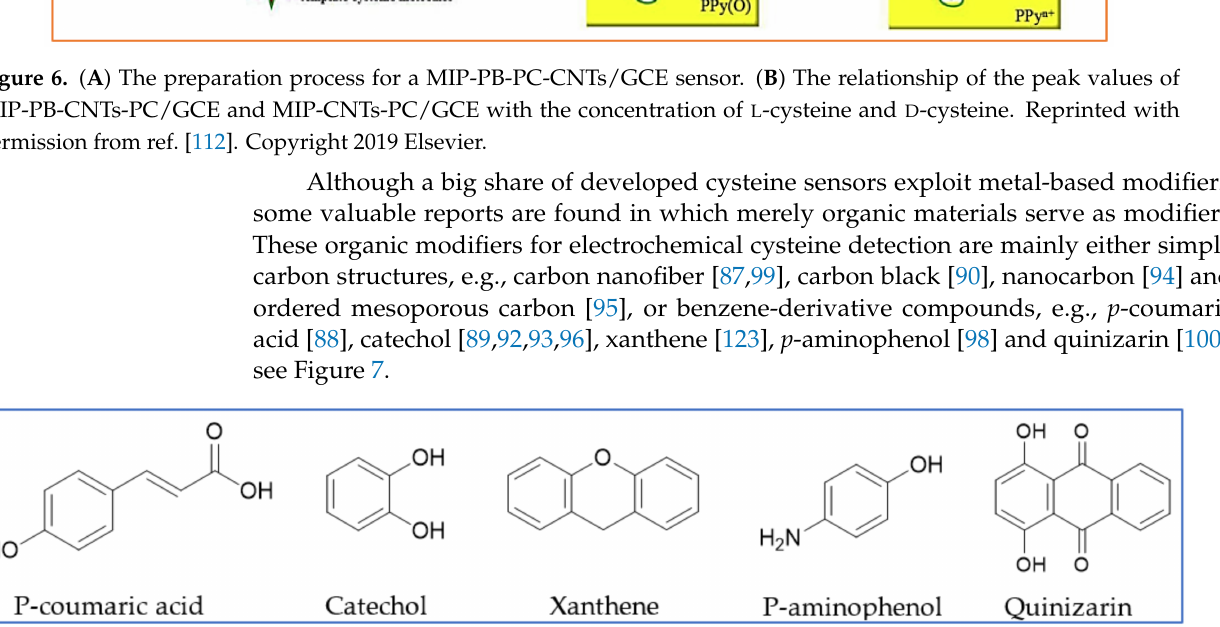
Figure 7. Benzene-derivative organic modifiers used in electrochemical cysteine